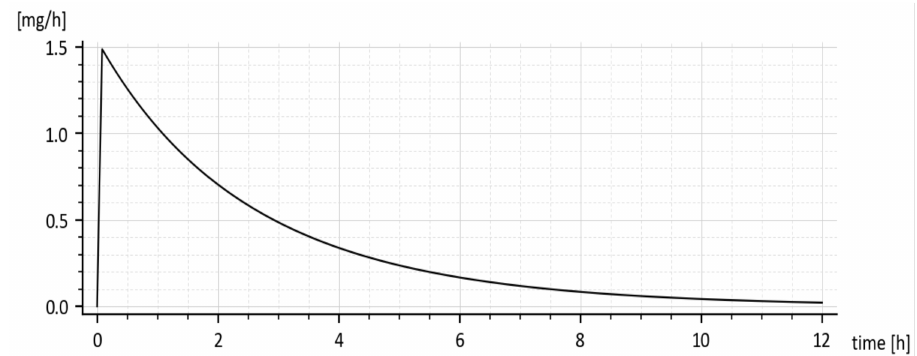
Figure 9. The predicted rate of drug absorption (without